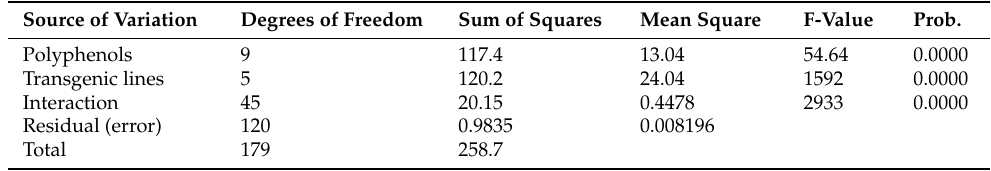
Table 2. Two-way ANOVA for HPLC